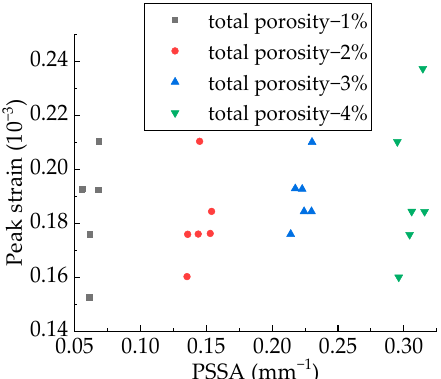
Figure 25. Relationship between the PSSA and the peak strain.